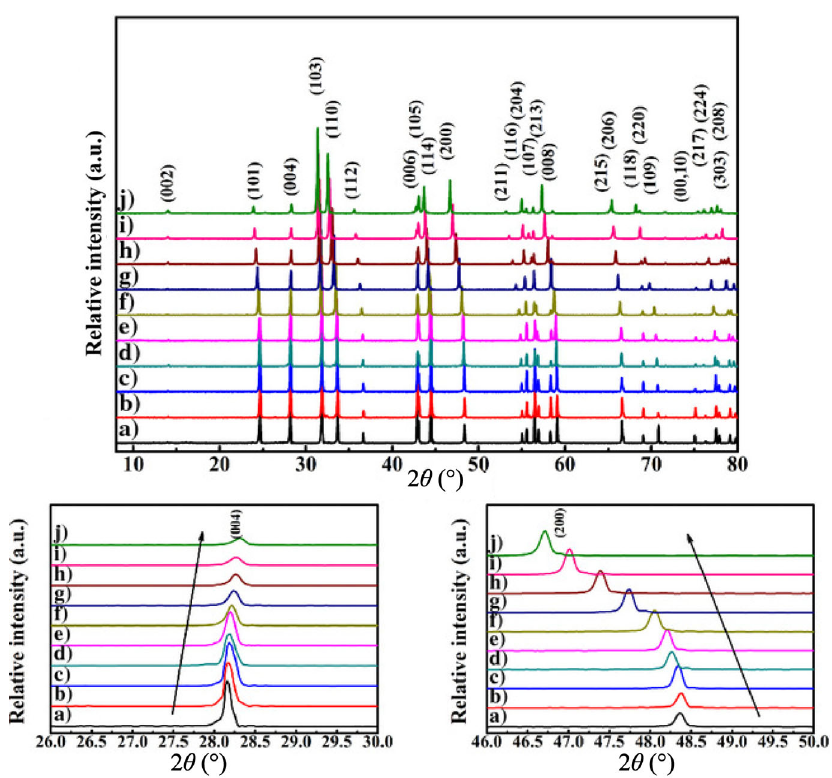
Fig. 27 XRD powder diffraction patterns of ceramics in (1 − x )SrLaAlO 4 – x Sr 2 TiO 4 system with enlarged (004) and (200) diffraction peaks: (a) x = 0, (b) x = 0.025, (c) x = 0.05, (d) x = 0.10, (e) x = 0.15, (f) x = 0.2, (g) x = 0.4, (h) x = 0.6, (i) x = 0.8, and (j) x = 1. Reproduced with permission from Ref. [569], © The American Ceramic Society 2011.